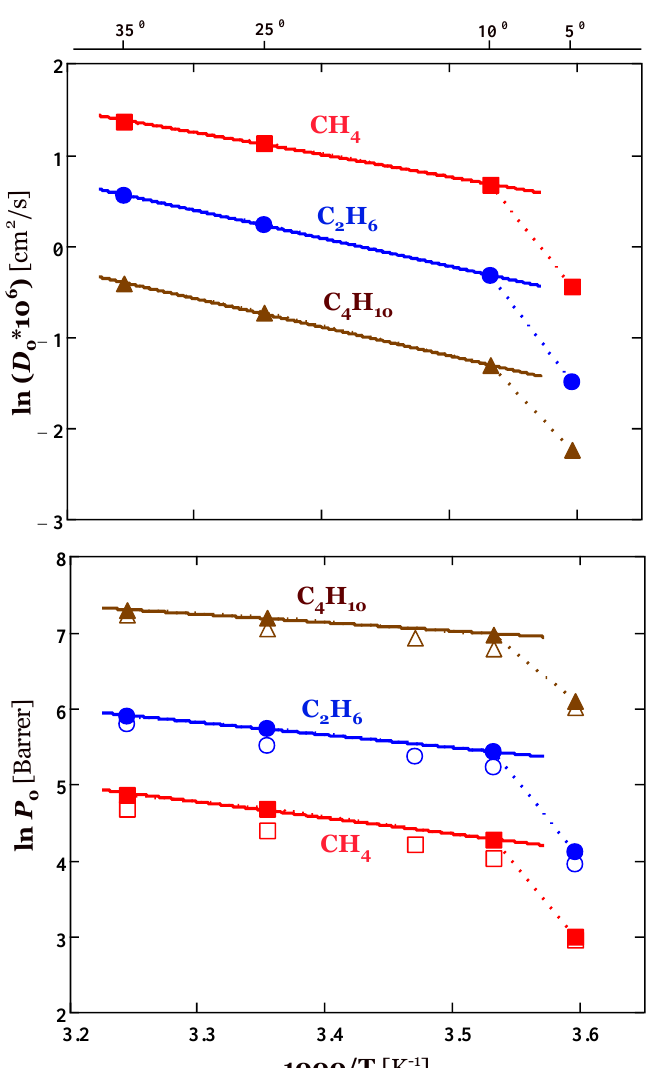
Figure 4. Temperature dependence of methane, ethane, and n -butane diffusivity D 0 and permeability P 0 in poly(tetradecyl methyl siloxane). The filled symbols represent values of D 0 and P 0 obtained by the sorption method, the solid lines represent the fits to diffusivity and permeability data using the Arrhenius-type relations (13) in the temperature range 10–35 ◦ C. The open symbols show permeability values determined by the permeation method.